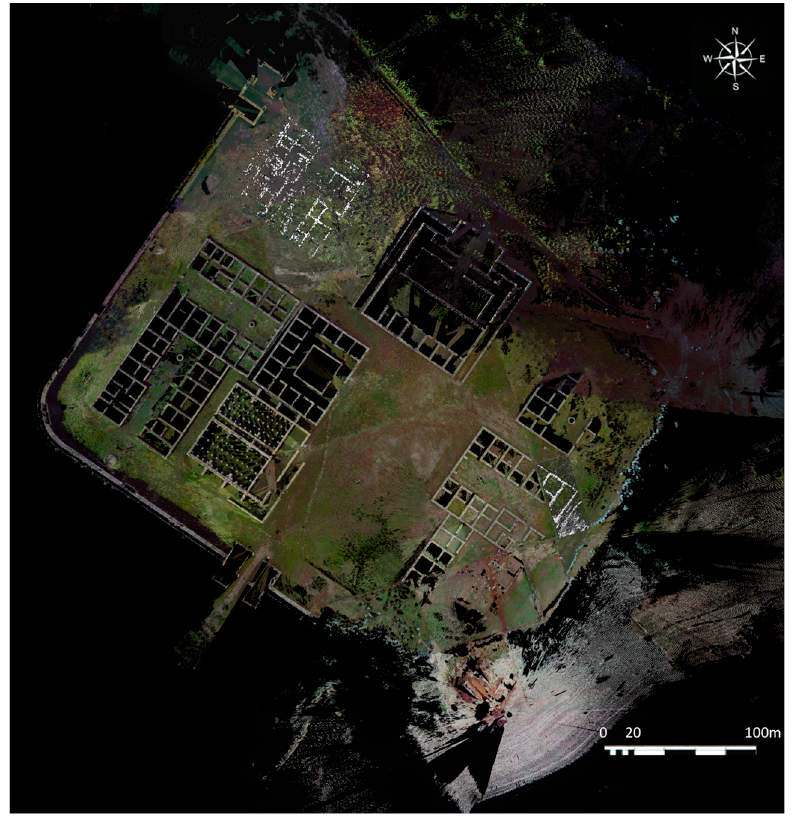
Figure 11. GPR results produced in grids 1 and 2, fused on the T-LiDAR based orthoimage of the Roman site.